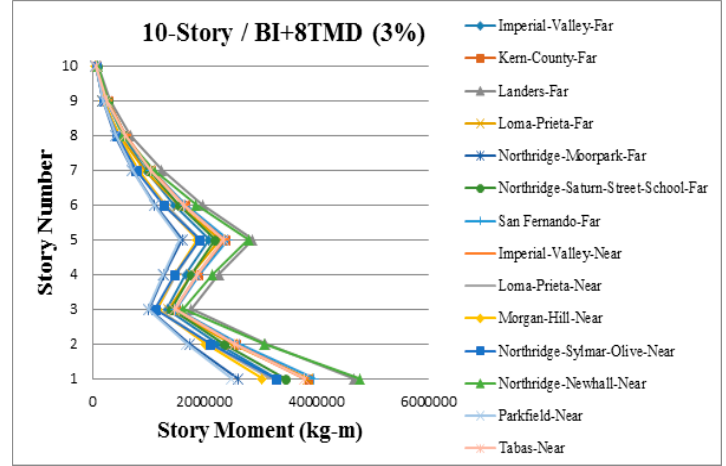
Figure 12. Peak story moments for 10-story base-isolated building with 4 TMDs.